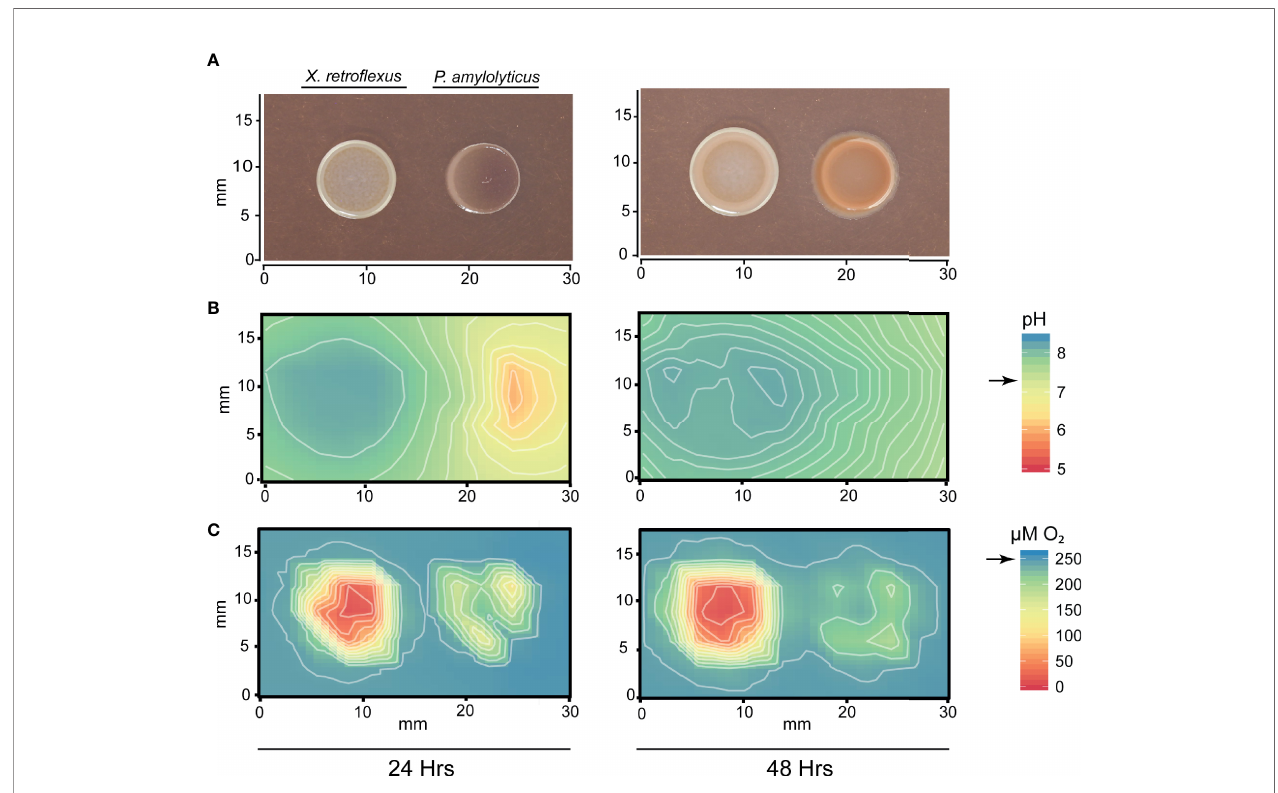
FIGURE 2 | Mapping of pH and O 2 concentration around colonies of X. retro fl exus and P. amylolyticus . (A) Colony morphology showing the changed morphology of P. amylolyticus at 24 and 48 hrs. (B) Distribution of pH around the bacterial colonies showing a change of pH in the interaction zone. X. retro fl exus was alkalizing the interaction zone from 24 hrs to 48 hrs. At 24 hrs, the backside of the P. amylolyticus colony was acidic, with a pH as low as 5-6. At 48 hrs the pH around the P. amylolyticus was shifted to approx. pH 7 from the pH drift caused by X. retro fl exus . Black arrow on scale bar indicates pH of TSA. (C) Distribution of O 2 concentration around the bacterial colonies showing a high O 2 consumption of X. retro fl exus and lower consumption from P. amylolyticus . Oxygen consumption of P. amylolyticus seemed restricted to the periphery of the colony at both 24 and 48 hrs, however with a lower consumption at 48 hrs. Black arrow on scale bar indicates oxygen level in TSA without inoculation of bacteria. Combined alkalization and high oxygen consumption of X. retro fl exus indicate a respiratory metabolism that is likely based on degradation of amino acids. In contrast, acidi fi cation and low oxygen consumption indicate a fermentative metabolism for P. amylolyticus . Plots of single species interactions are available for X. retro fl exus in Figure S1 and for P. amylolyticus in Figure S2